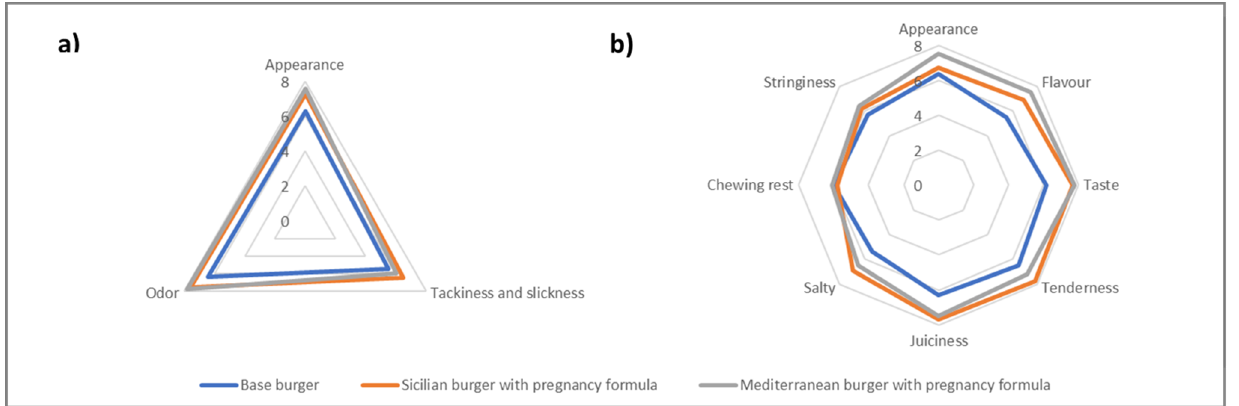
Figure 1. Sensory analysis of control and fortified (pregnancy woman) Sicilian and Mediterranean burgers, considering both raw ( a ) and cooked ( b ) products. Data are reported in terms of mean ± standard deviation ( n = 11). Scores are based on a 0–8-point numeric scale.